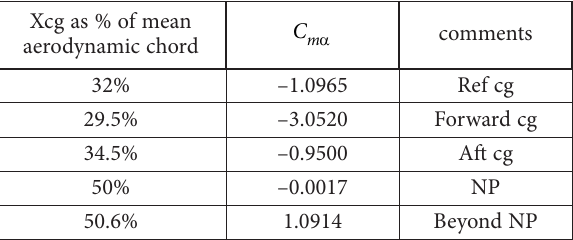
Table 8. Variable longitudinal static stability Xcg as % of mean aerodynamic chord